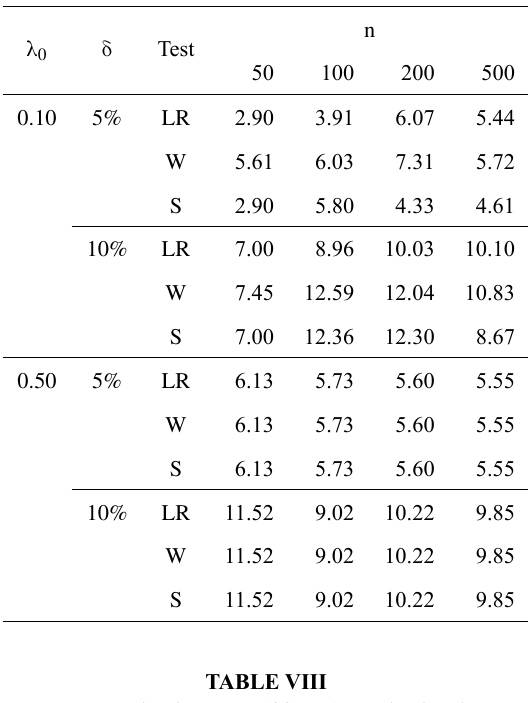
Nonnull rejection rates (%), ZOIK distribution,